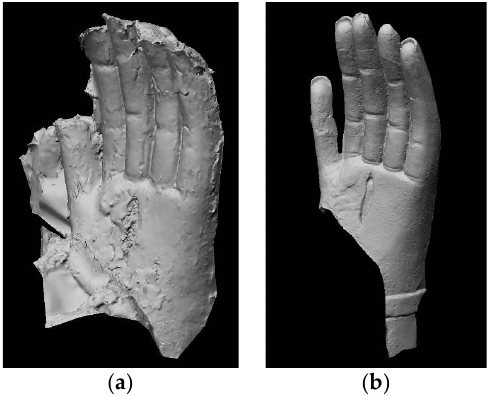
Figure 7. ( a ) LOD2—the micro-scene, comprising 3D point cloud of a Guanyin hand in 2011; ( b ) The 3D model is the result of virtual restoration, one special eye (heavenly eye) in the palm of hand and finger joints shown high ability to express geometric details.